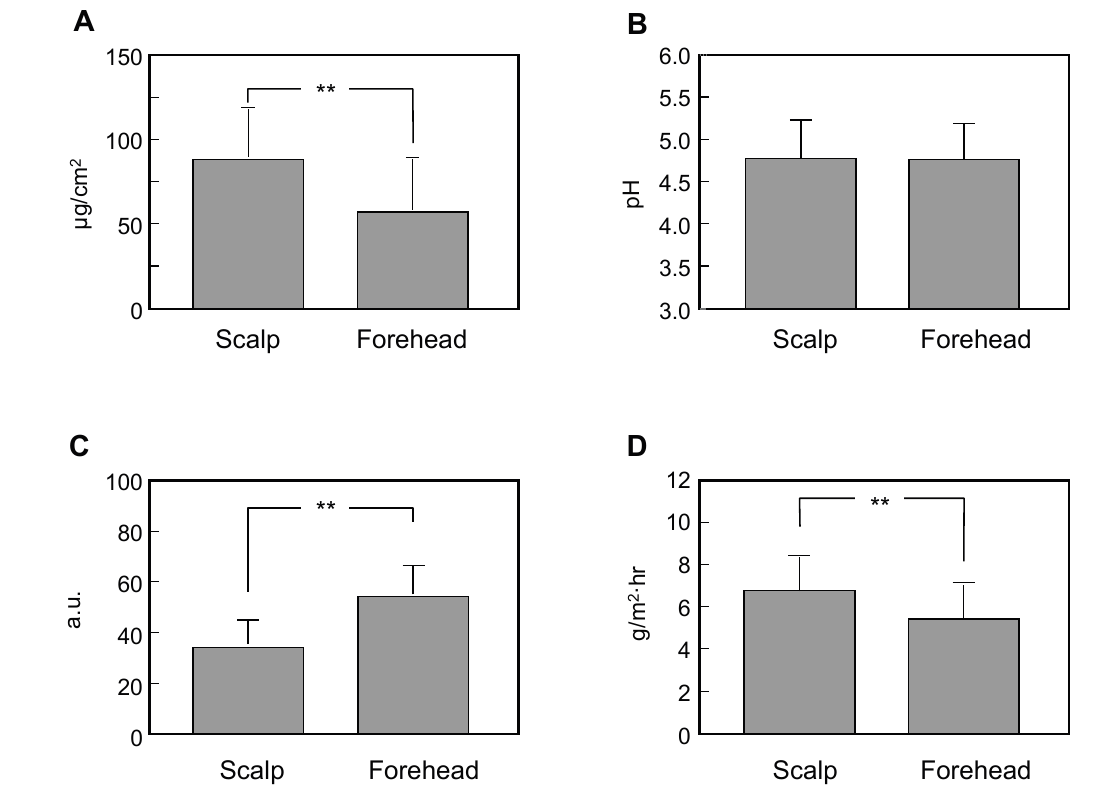
Figure 1. Comparison of measured data for sebum level ( A ), skin surface pH ( B ), MRA ( C ), and TEWL ( D ) between the scalp and the forehead. Each column indicates the average and the bars show standard deviation. ** indicates p < 0.01 as a significant